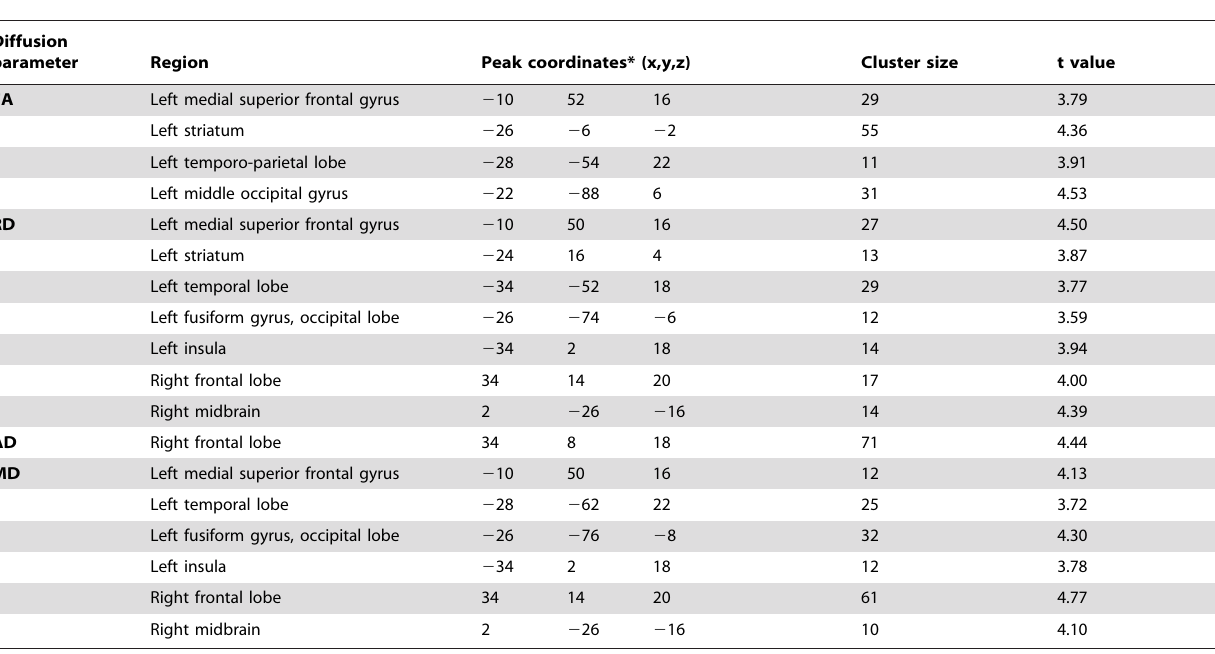
Table 2. Areas of abnormal DTI-derived parameters in 27 patients with obsessive-compulsive disorder and 23 healthy controls before